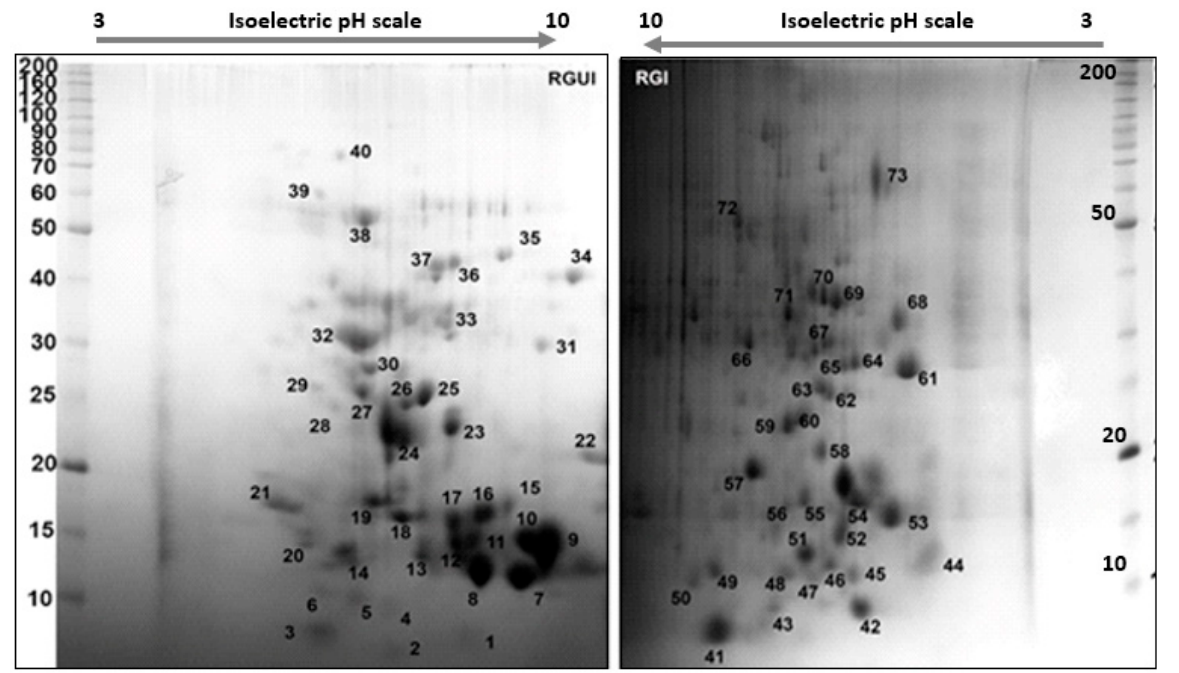
Figure 8. SDS-PAGE profile of the protein samples taken from the infected and non-infected rice grains of the Dharam variety and the resistant Black rice variety. Note: MW = molecular weight marker, DRI = Dharam rice grains infected, DRUI = Dharam rice grains non-infected, and BRR = Black rice-resistant variety.